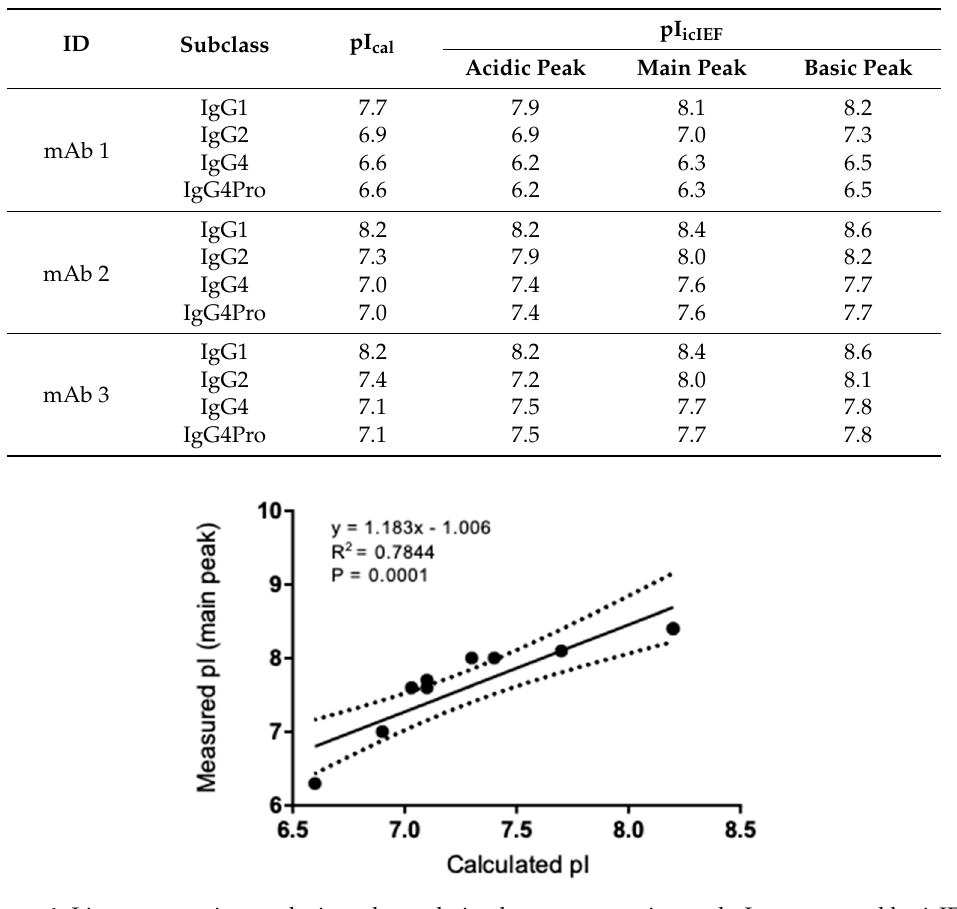
Figure 4. Linear regression analysis and correlation between experimental pI as measured by icIEF and theoretical pI calculated from the IgG sequence. Dotted lines indicate the 95% confidence interval.